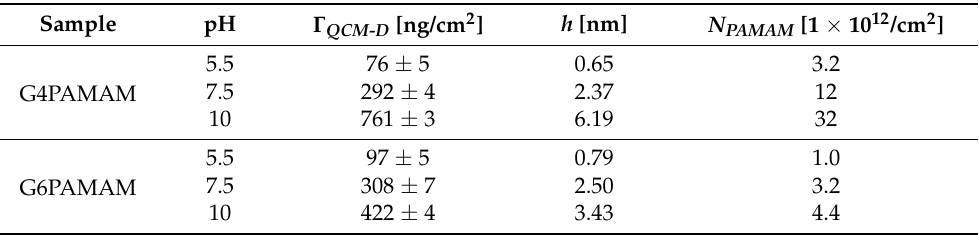
Table 3. QCM-D results for G4PAMAM (c = 17.6 µ M) and G6PAMAM (c = 4.3 µ M) (d = 1.23 g/cm 3